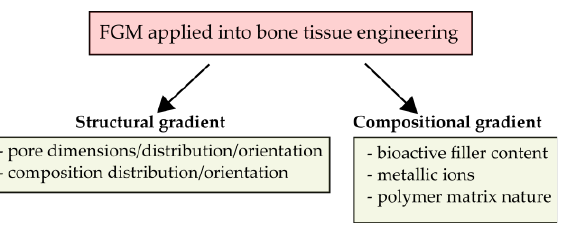
Figure 4. Diagram of the different FGM strategies for bone tissue engineering.